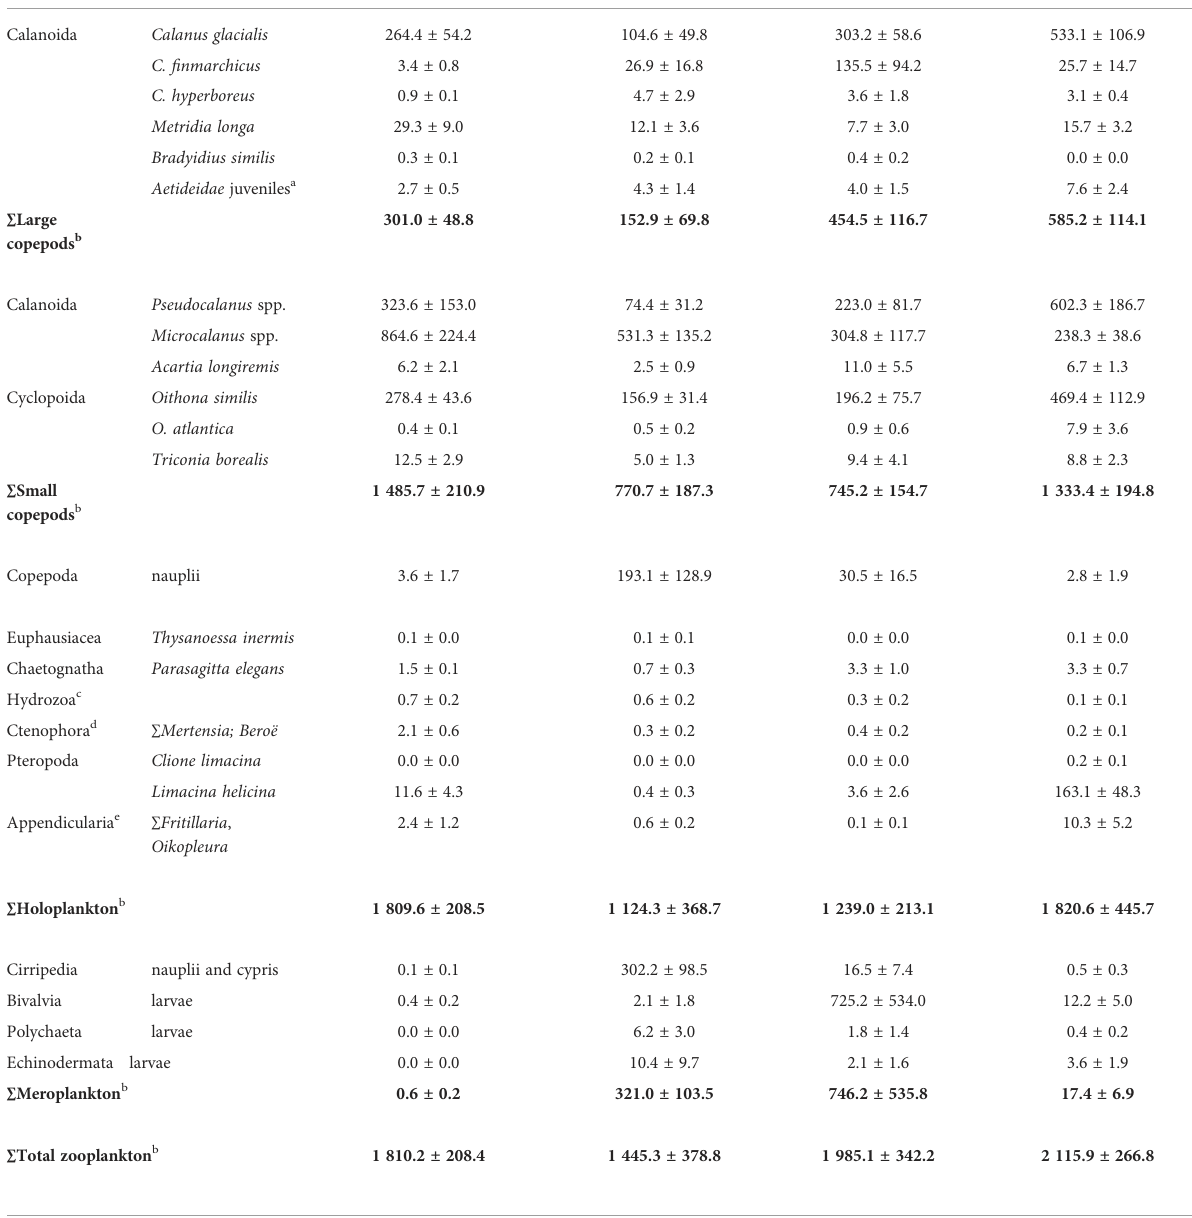
TABLE 2 Overview of main zooplankton species/ taxa (ind. m -3 ) in Billefjorden, Svalbard, divided into the four seasons: Winter, Spring, Summer and Autumn according to similarity (cluster) analyses on integrated zooplankton densities (see Figure 4). Group